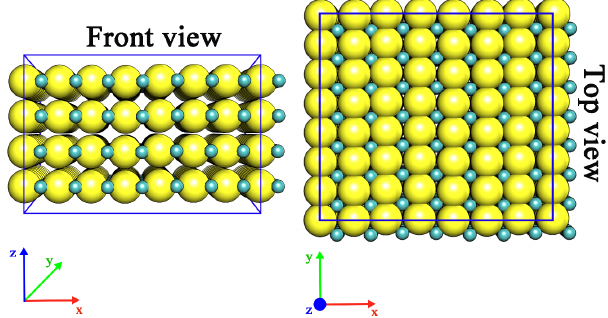
Figure 1. Front view and Top view of 4L MoS 2 . Mo atoms were reported in green sticks, while S atoms were highlighted in yellow VdW spheres.